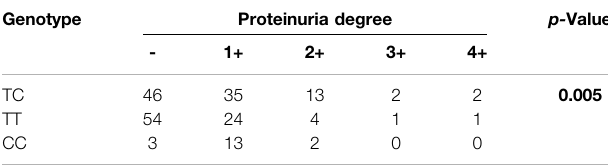
TABLE 4 | Distributions and analysis of rs3804099 in patients with proteinuria.